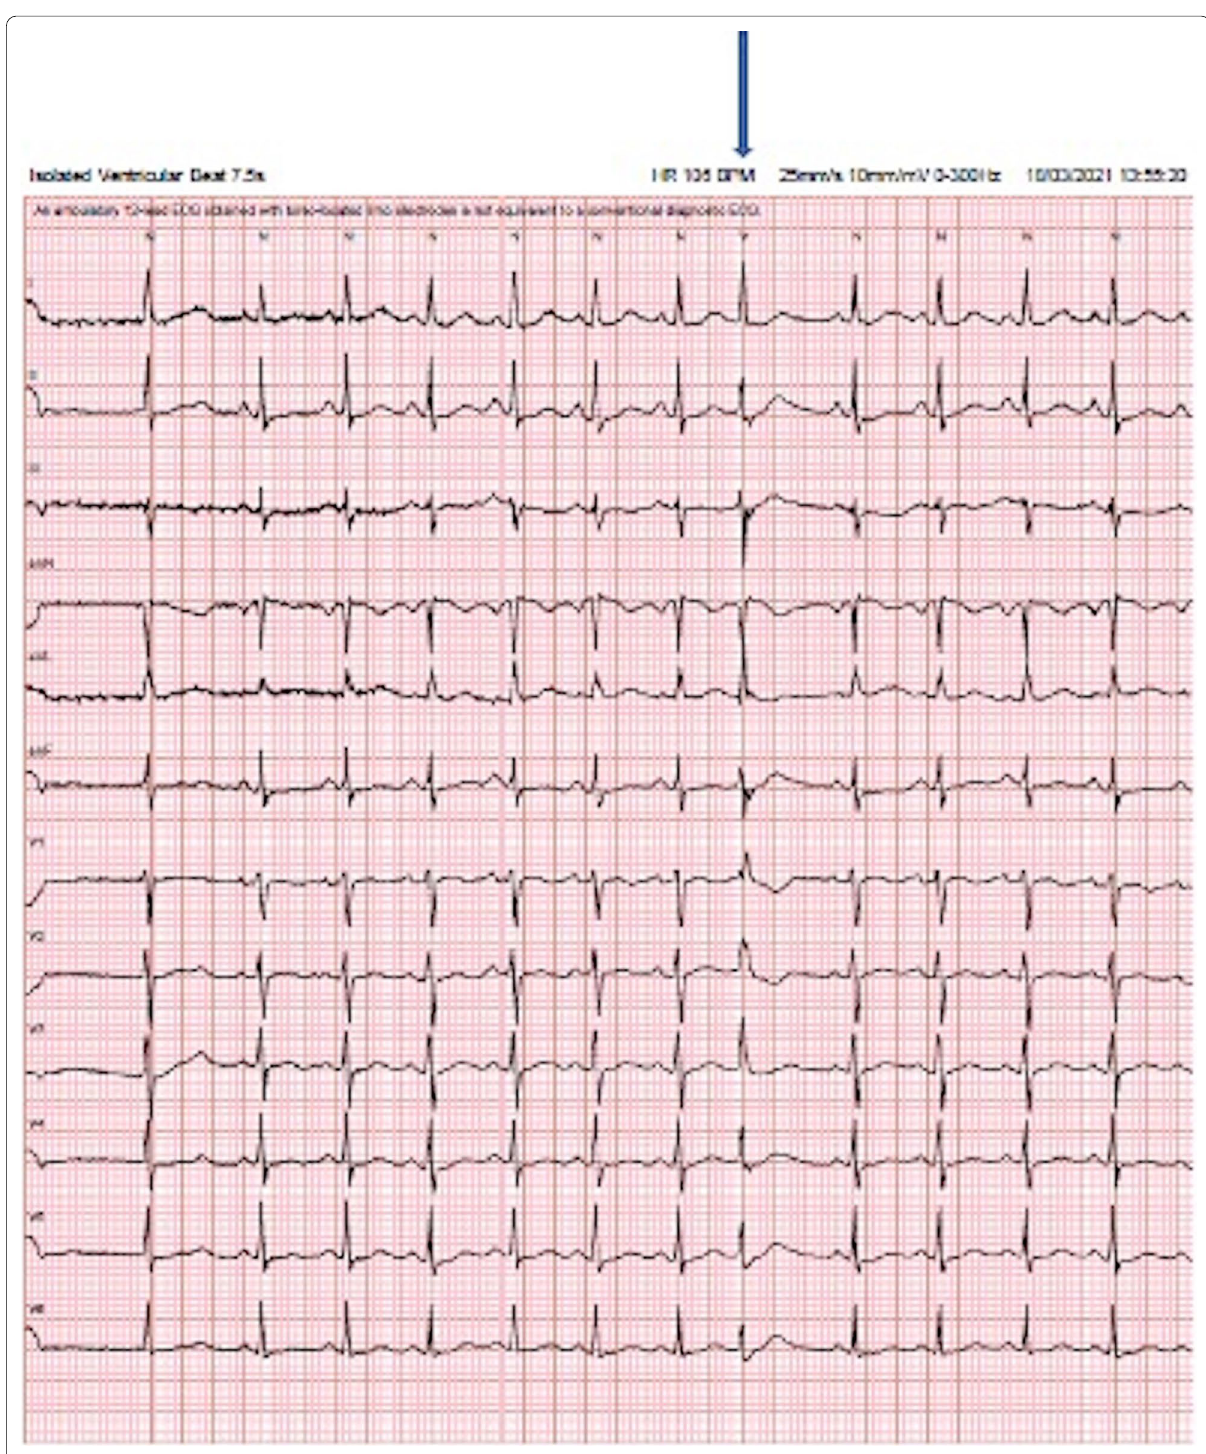
Fig. 2 Very narrow QRS in a RBBB pattern with a normal axis. The VE is barely distinguishable from sinus beat in lead 1 (see arrow). The very narrow QRS and the r > R ′ pattern in V1 strongly suggest a fascicular